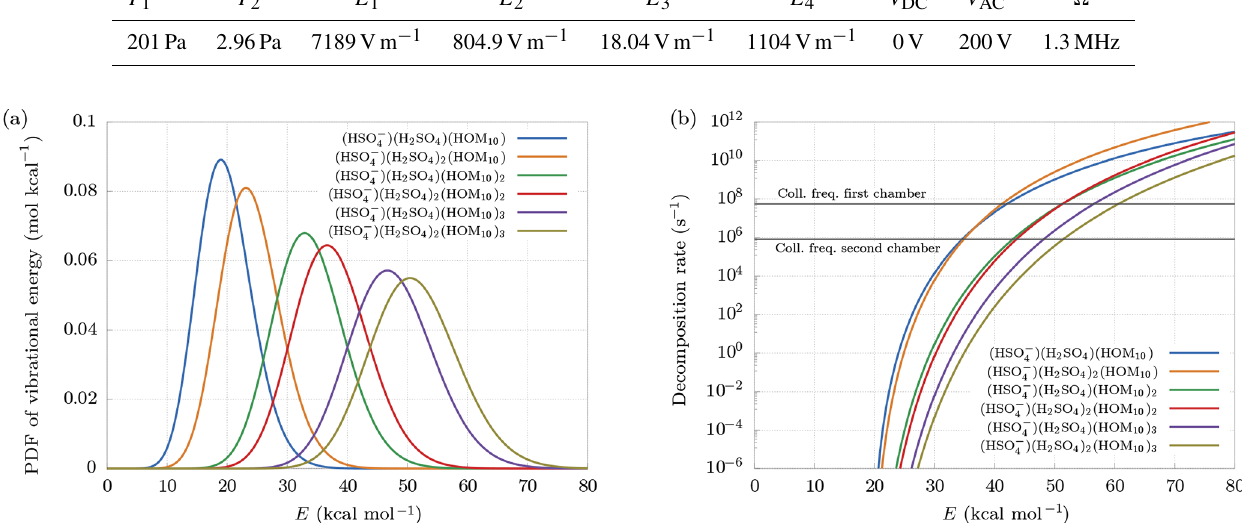
Figure 6. (a) Distribution of vibrational energy at equilibrium at temperature T = 300K. (b) Decomposition rate constants at E f = 20kcalmol − 1 . Collision frequencies in the first and second chambers are shown as reference.